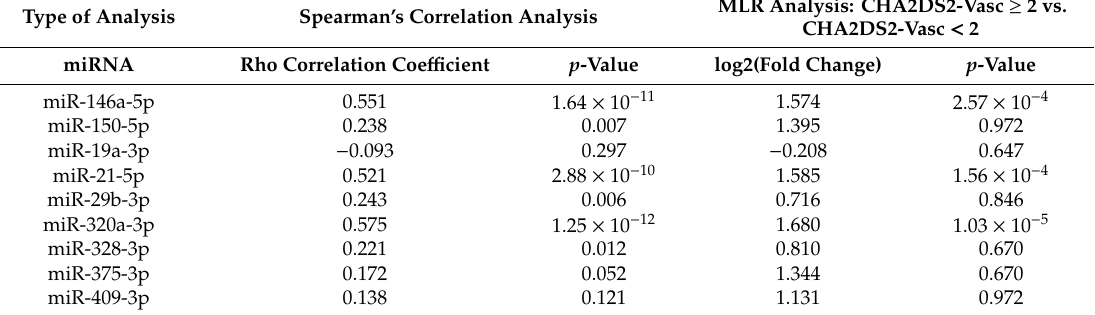
Table 4. Association between relative miRNA plasma levels and the CHA 2 DS 2 -Vasc score in the study sample.